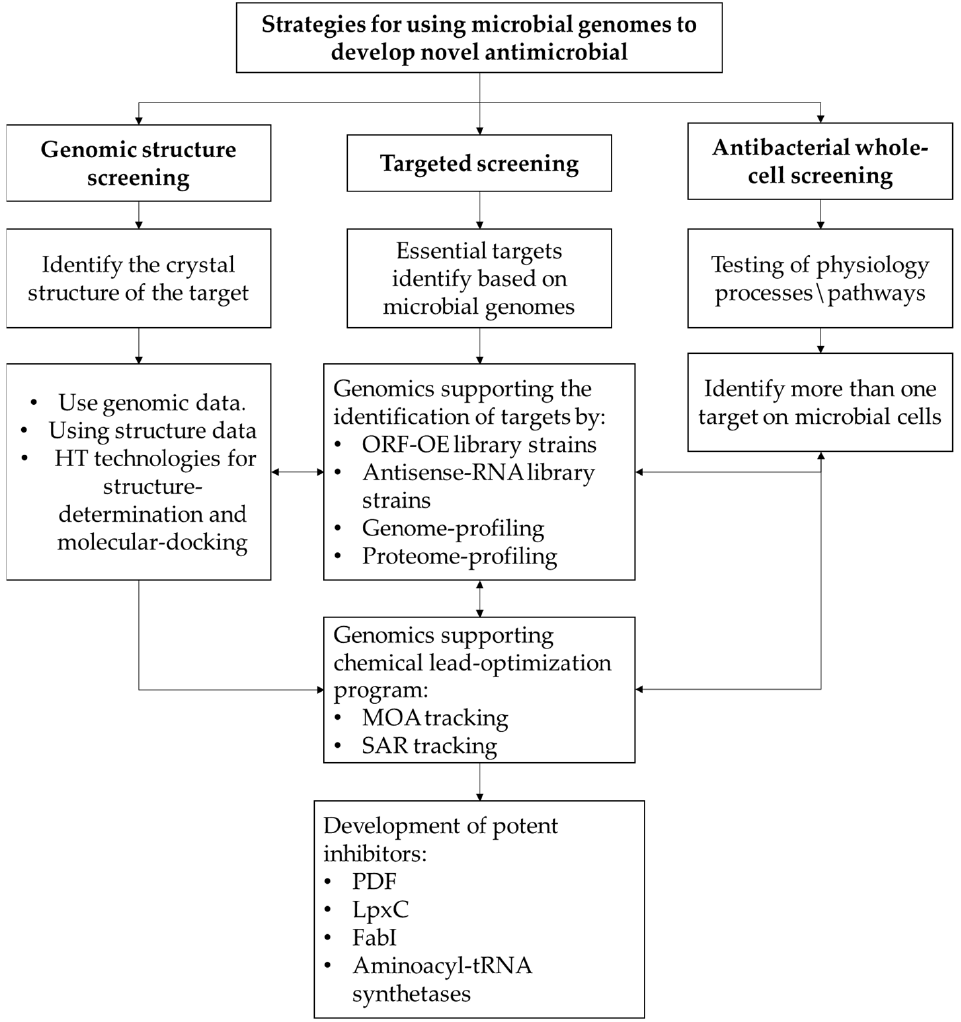
Figure 2. Flowchart of different strategies of using genomics to discover antibacterial.